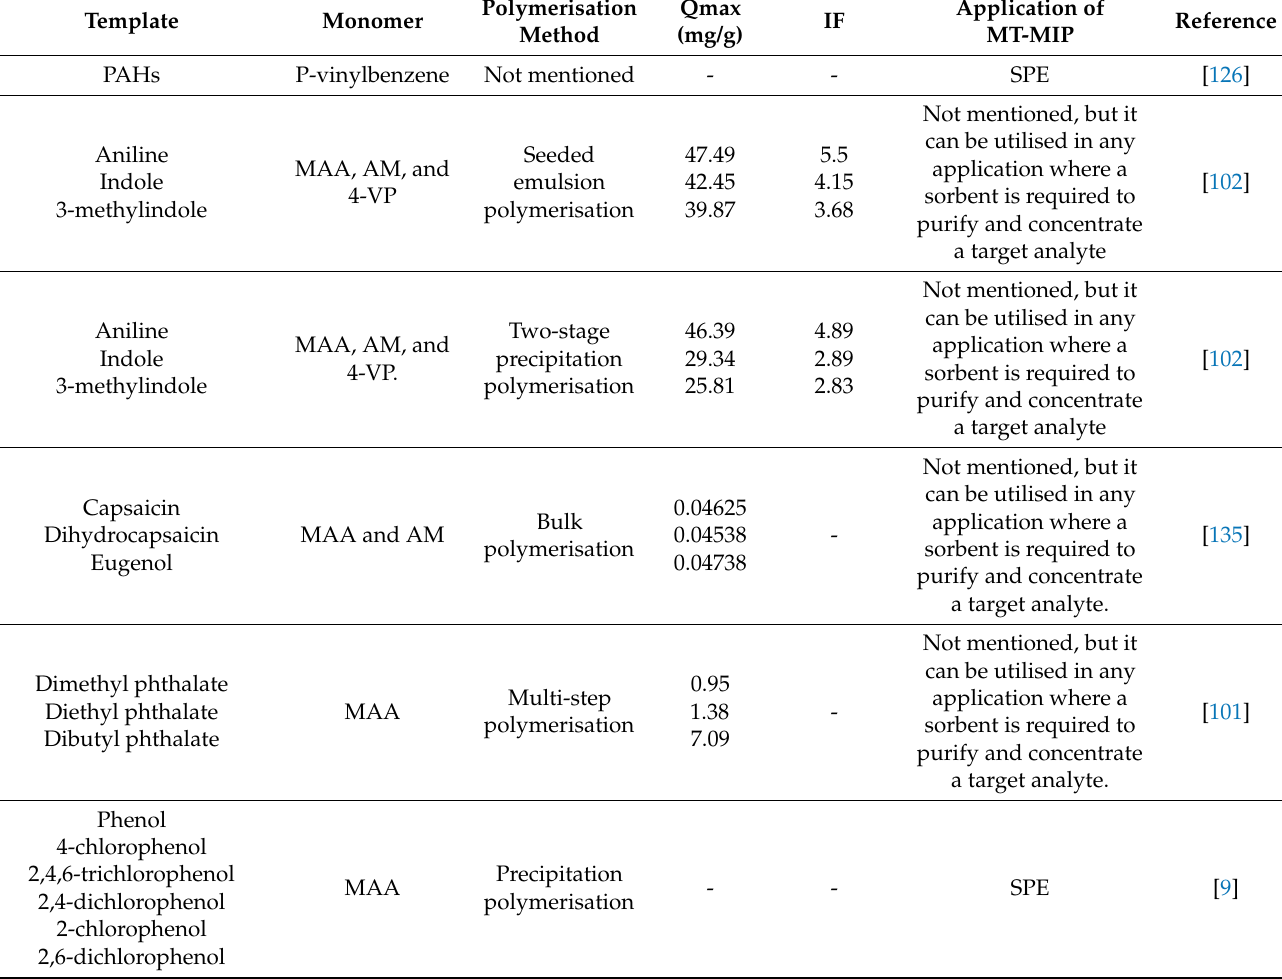
Table 5. Organic molecules used as templates for multi-template molecularly imprinted